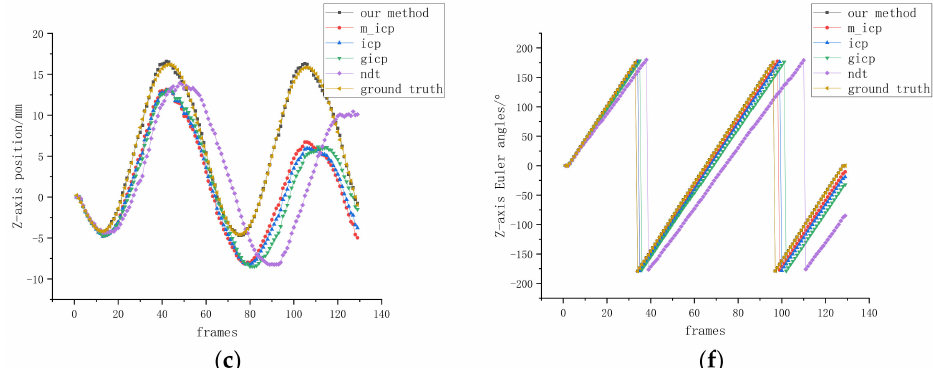
Figure 10. Comparison of pose-estimation results for the rotation experiment. ( a ) X-axis translation; ( b ) Y-axis translation; ( c ) Z-axis translation; ( d ) X-axis Euler angle; ( e ) Y-axis Euler angle; ( f ) X-axis Euler angle.